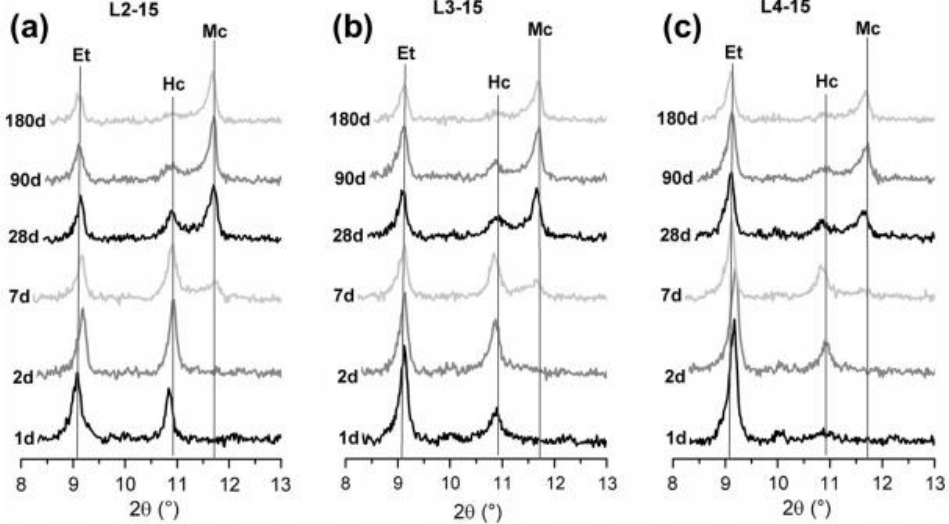
Figure 3. Influence of different quantities of anhydrite on the hydration of laboratory limestone (LS) containing Portland cements: ( a ) 2.1% CaSO 4 + 15% LS, ( b ) 3% CaSO 4 + 15% LS, and ( c ) 3.8% CaSO 4 + 15% LS. The main reflexes of ettringite (Et), hemicarbonate (Hc), monocarbonate (Mc) are indicated [51].